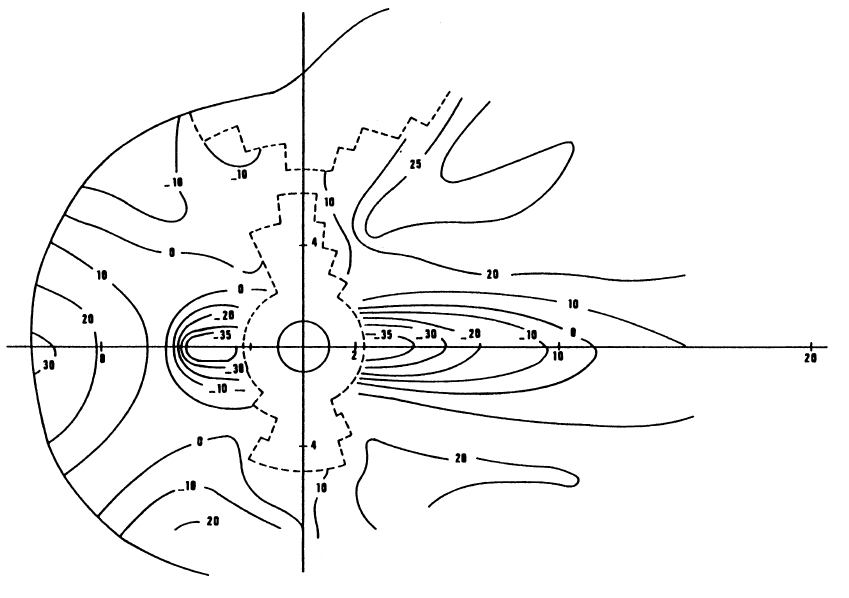
Fig. 8. The experimental D B contours have been plotted for Kp = 1. D B is the scalar di(cid:128)erence between the total field and the internal field of the Earth. These contours are averaged over the tilt. The step between two contours is 10 nanoteslas